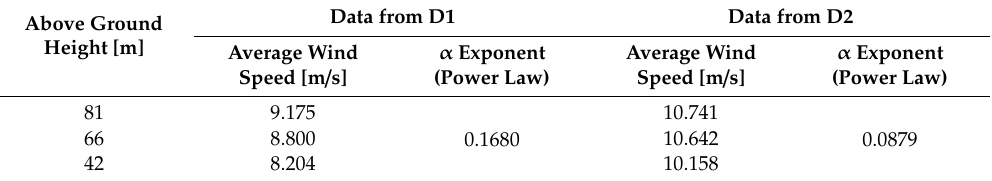
Table 2. Characterization of the wind speed vertical profile of D1 and